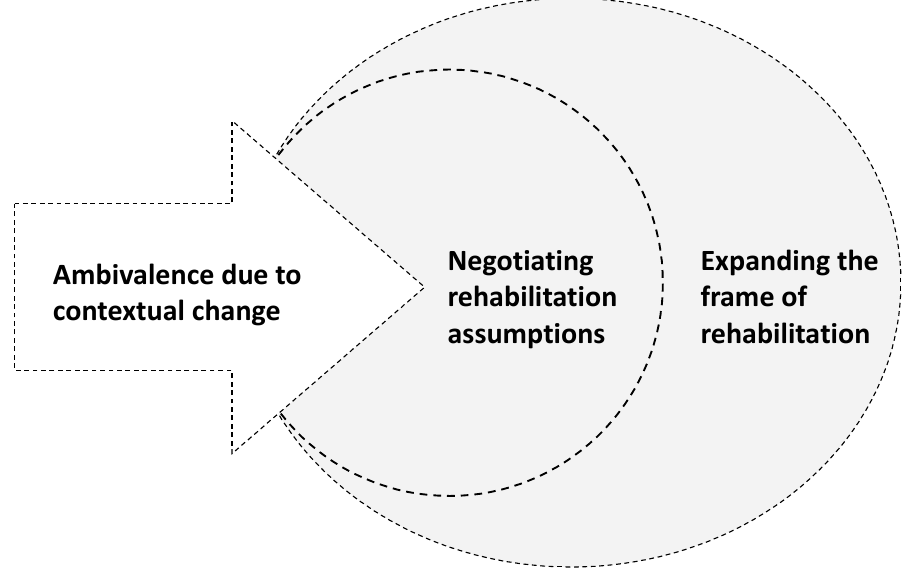
Figure 2. To convert ambivalence into possibilities of expanding the frame of rehabilitation, the assumptions of people with disabilities and health professionals were negotiated.